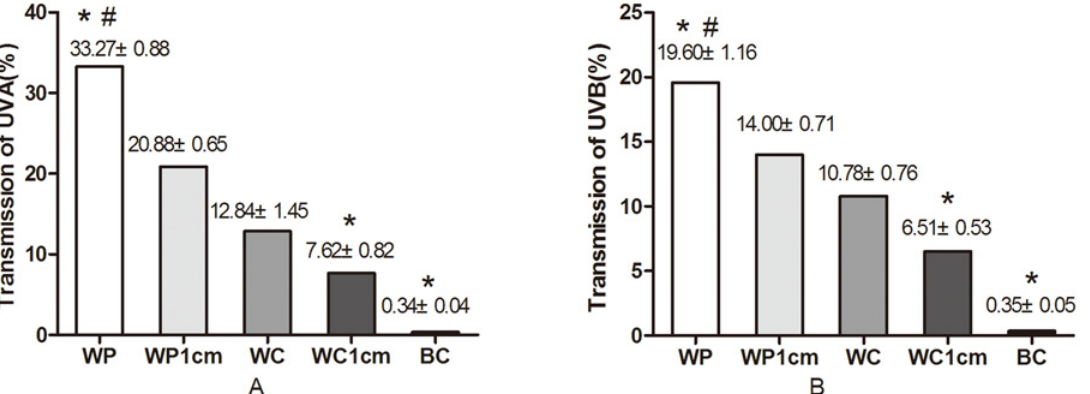
Fig 2. Ultraviolet light transmission through different types of clothing (%). WP, White Polyester; WC, White Cotton; BC, Black Cotton. WP1cm and WC1cm indicate that the distance between the clothing and the skin was 1 centimeter. * The transmission through this type of clothing was significantly different ( P < 0.05) from that through WC. # The transmission through WP was significantly different ( P < 0.05) from that through WP1cm.